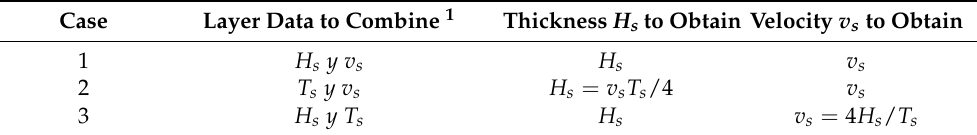
Table 5. Combination values of the homogeneous layer for soil microzoning, adapted with permission from Ulises Mena, Comisi ó n Federal de Electricidad Manual de Diseño de Obras Civiles; published by Comision Federal de Electricidad (CFE), 2015 [1].